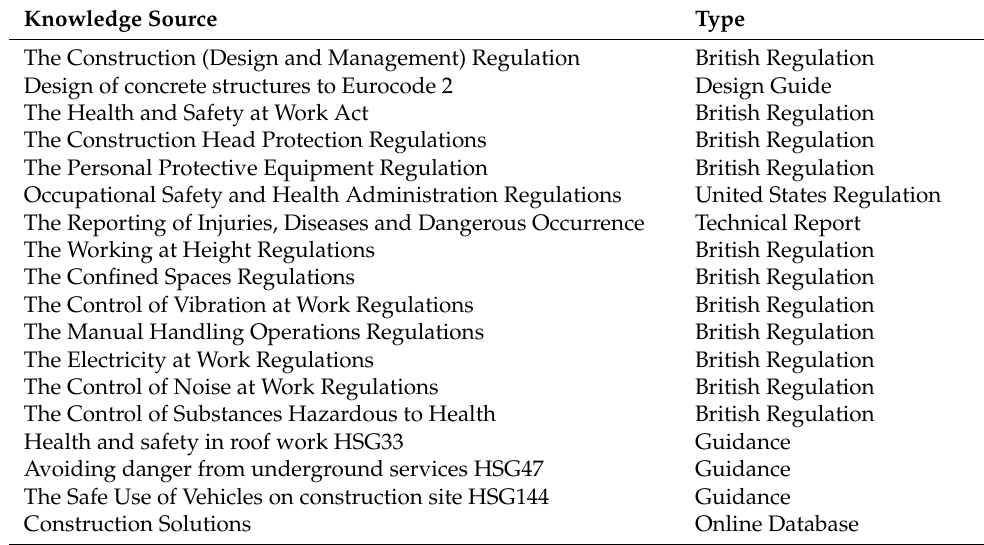
Table 1. Knowledge Sources of HSM-Onto.